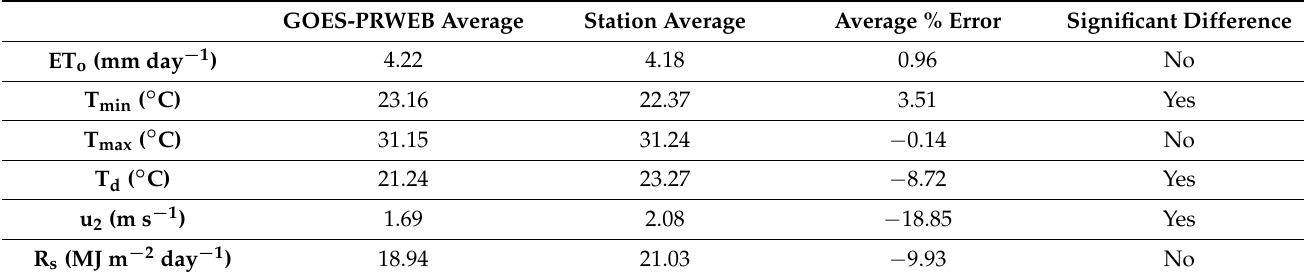
Table 1. Statistical results of ET o and weather parameters associated with data presented in Figures 2 and A1–A5. GOES-PRWEB